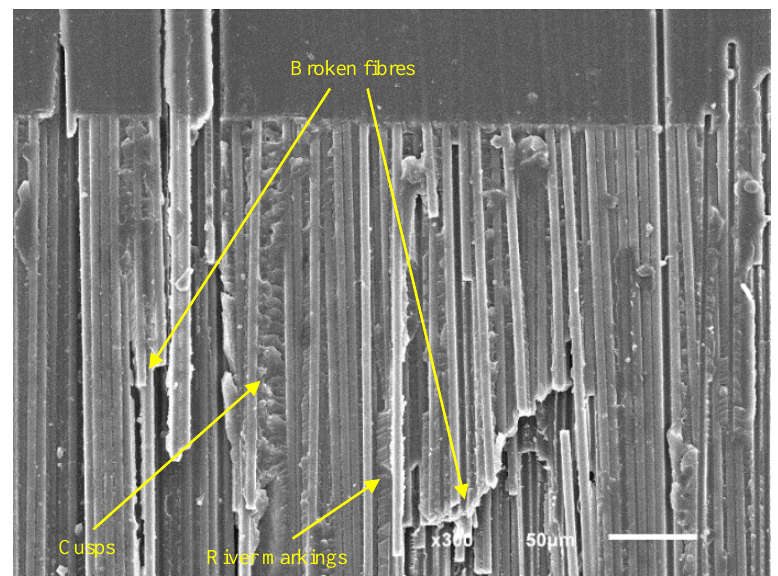
Figure 11. SEM micrographs of an ADCB fatigue specimen showing the presence of broken fibers, cusps, and river markings.